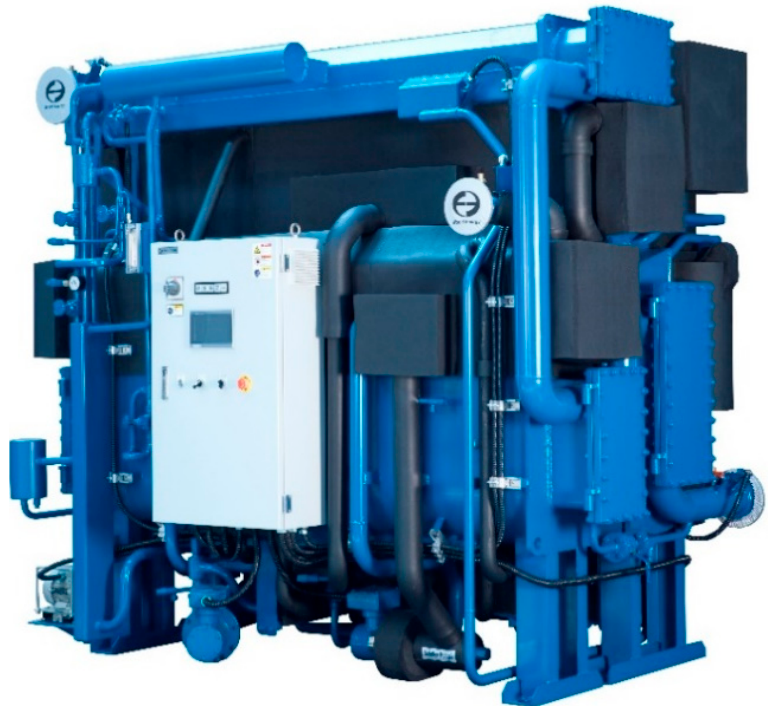
Figure 8. Single-e ff ect double-lift water / LiBr absorption chiller developed by the World Energy Co., Ltd. Figure 8. Single ‐ effect double ‐ lift water/LiBr absorption chiller developed by the World Energy Co., Adapted from Reference Ltd. Adapted from Reference [36].